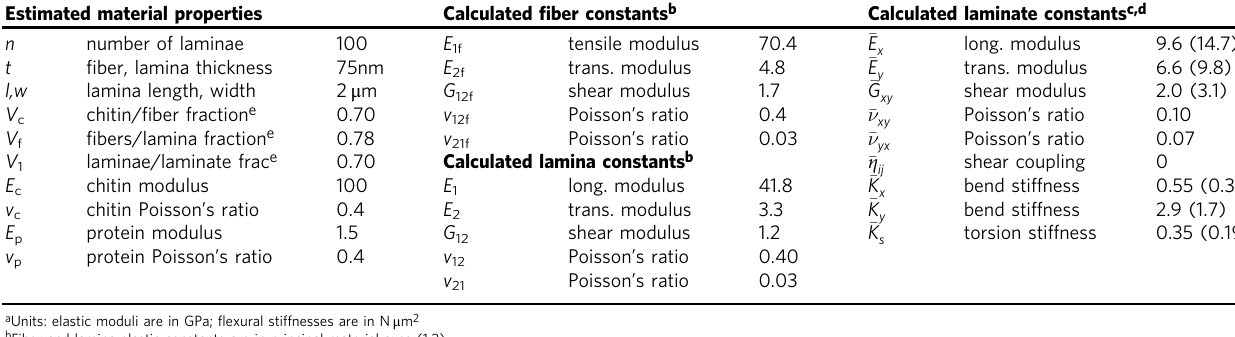
Table 1 Estimated material properties and calculated elastic constants for fi ber, lamina and laminate a . Estimated material